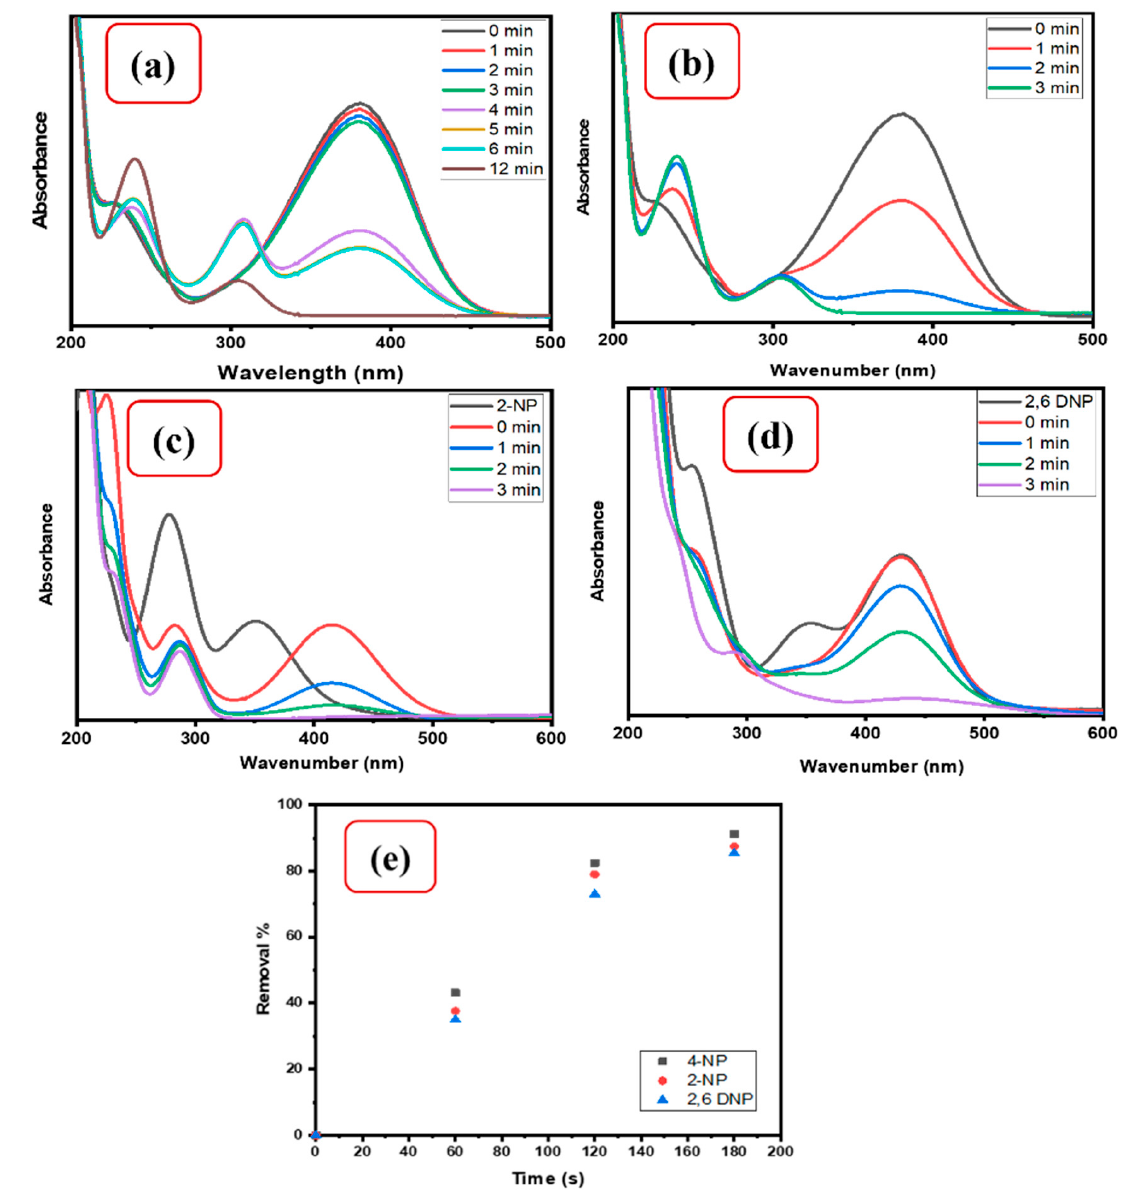
Figure 5. ( a ) UV–Vis spectra for 4-NP reduction using 5 mg CuO-TiO 2 in the presence of NaBH 4 , ( b – d ), 4-NP, 2-NP, and 2,6-DNP reduction using 5 mg CMC/CuO-TiO 2 in the presence of NaBH 4 , ( e ) removal percentage of 4-NP, 2-NP and 2,6-DNP using 5 mg CMC/CuO-TiO 2 in the presence of NaBH 4 .